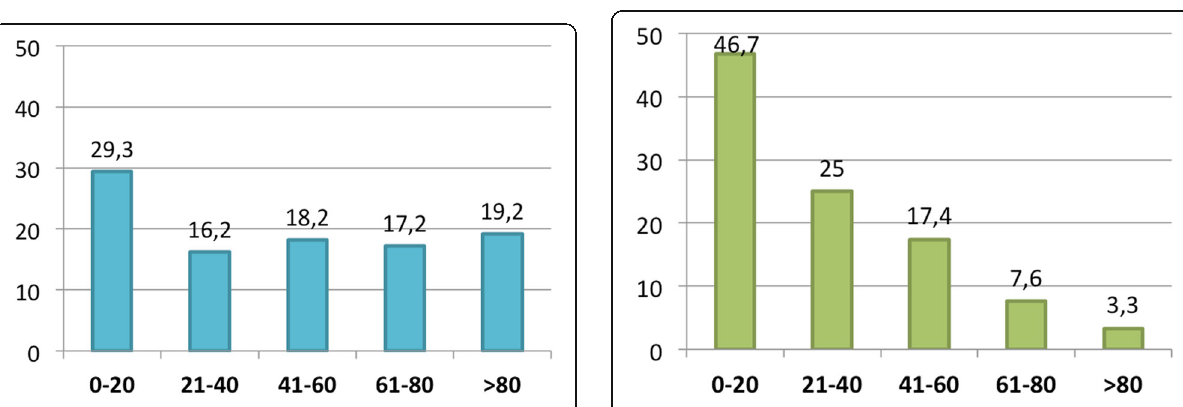
Fig. 7 Discontinuation trial of OnabotA in case of efficacy: percentage of cases in which responders try to discontinue OnaboA in case of efficacy